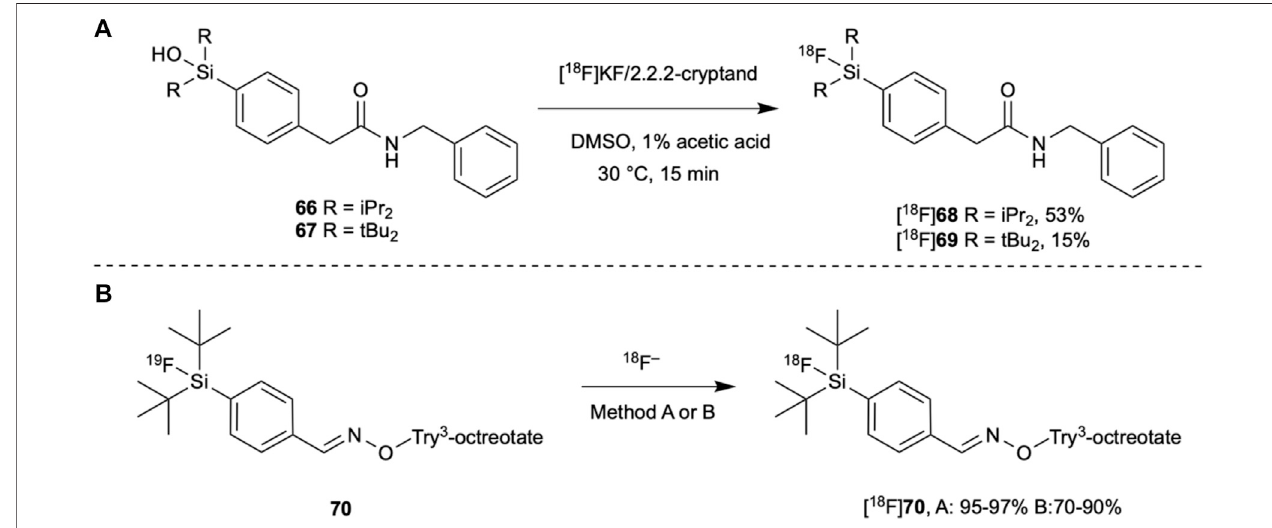
FIGURE 8 | ( A ) Silanols can be radiolabeled with [ 18 F] fl uoride at room temperature in organic solvents though bulker substituents on the silicon atom result in a lower yield. ( B ) Try 3 -octreotate has been radiolabeled with [ 18 F] fl uoride in both organic and aqueous solvents. Method A: [ 18 F]KF/Krypto fi x 222, MeCN, rt, 10 – 15